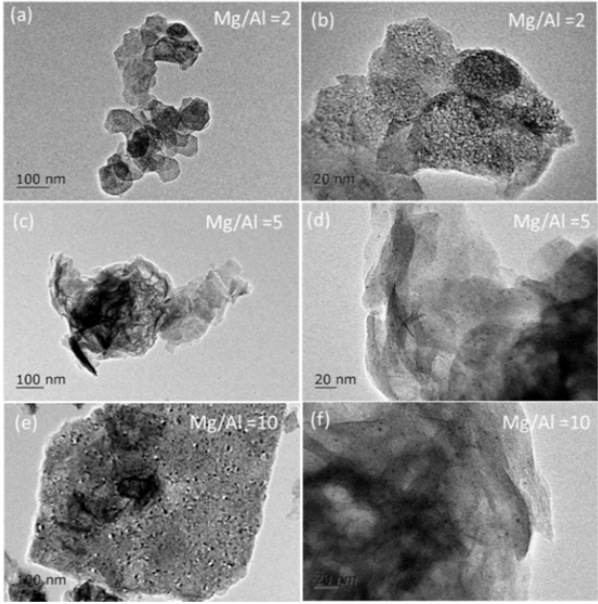
Figure 4. TEM images of PtSn/Mg(Al)O: ( a , b ) Mg:Al = 2:1; ( c , d ) Mg:Al = 5:1; ( e , f ) Mg:Al = 10:1.